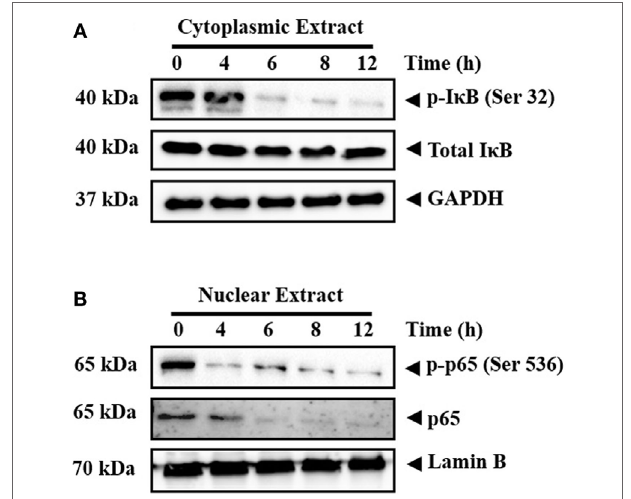
FigUre 4 | (a) The effect of CMO on constitutive NF- κ B DNA-binding activity. HepG2 cells (5 × 10 5 /ml) and HCCLM3 cells (5 × 10 5 /ml) were treated with CMO for 4, 8, and 12 h. Nuclear extracts were prepared, 50 µg of the nuclear extract protein was taken for DNA-binding assay as described in Section “Materials and Methods.” (B,c) CMO inhibits constitutive activation of reporter gene expression. HepG2 (5 × 10 5 /ml) and HCCLM3 (5 × 10 5 /ml) cells were transfected with NF- κ B luciferase and β -galactosidase reporter plasmid using lipofectamine, incubated for 24 h, and then treated with CMO for 4, 8, and 12 h. Cells were lysed in reporter lysis buffer and analyzed for luciferase activity and normalized with β -galactosidase activity. Results are expressed as % fold activity over the activity of vector control. * p <